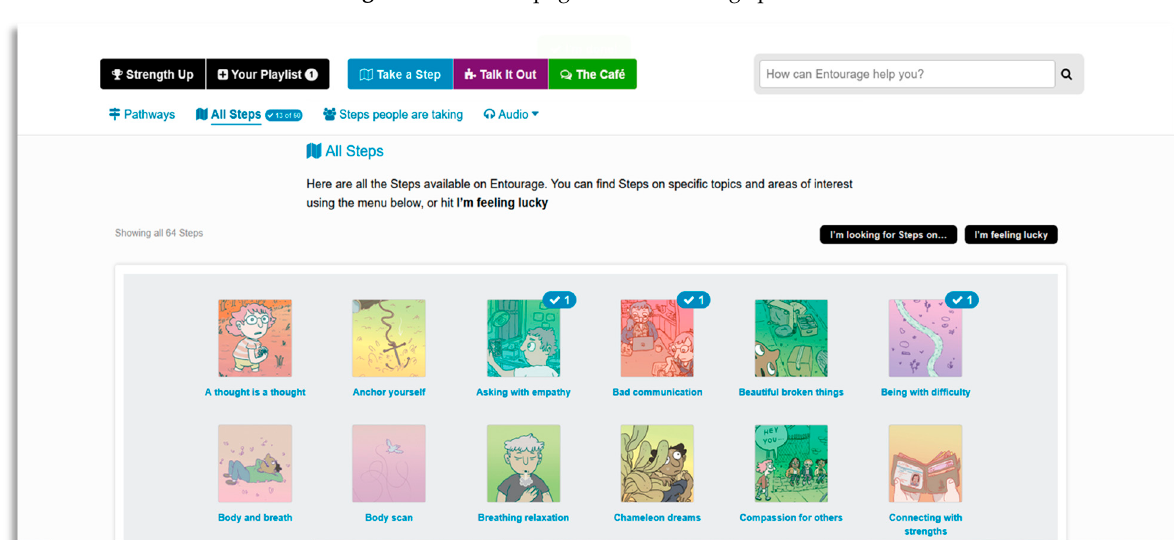
Figure 2. Welcome page of the Entourage platform.